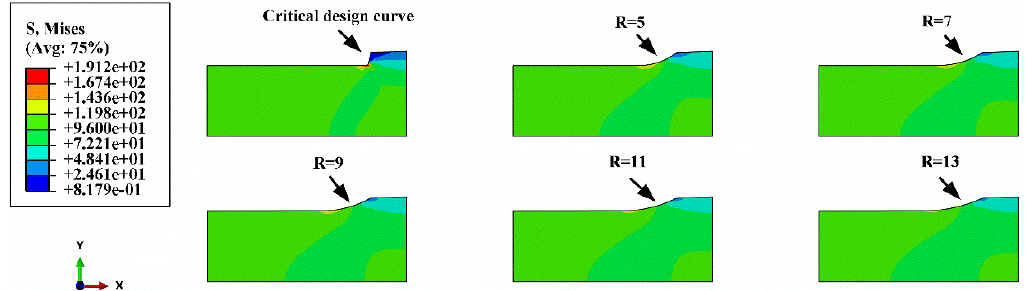
Figure 9. Numerical results of Mises stress distribution with different fillet radii.